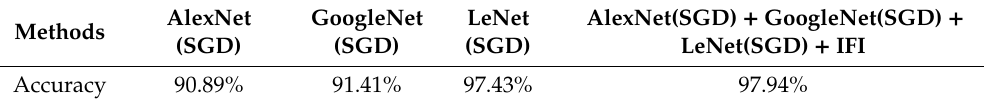
Table 9. Recognition results of di ff erent architectures with SGD optimization method.